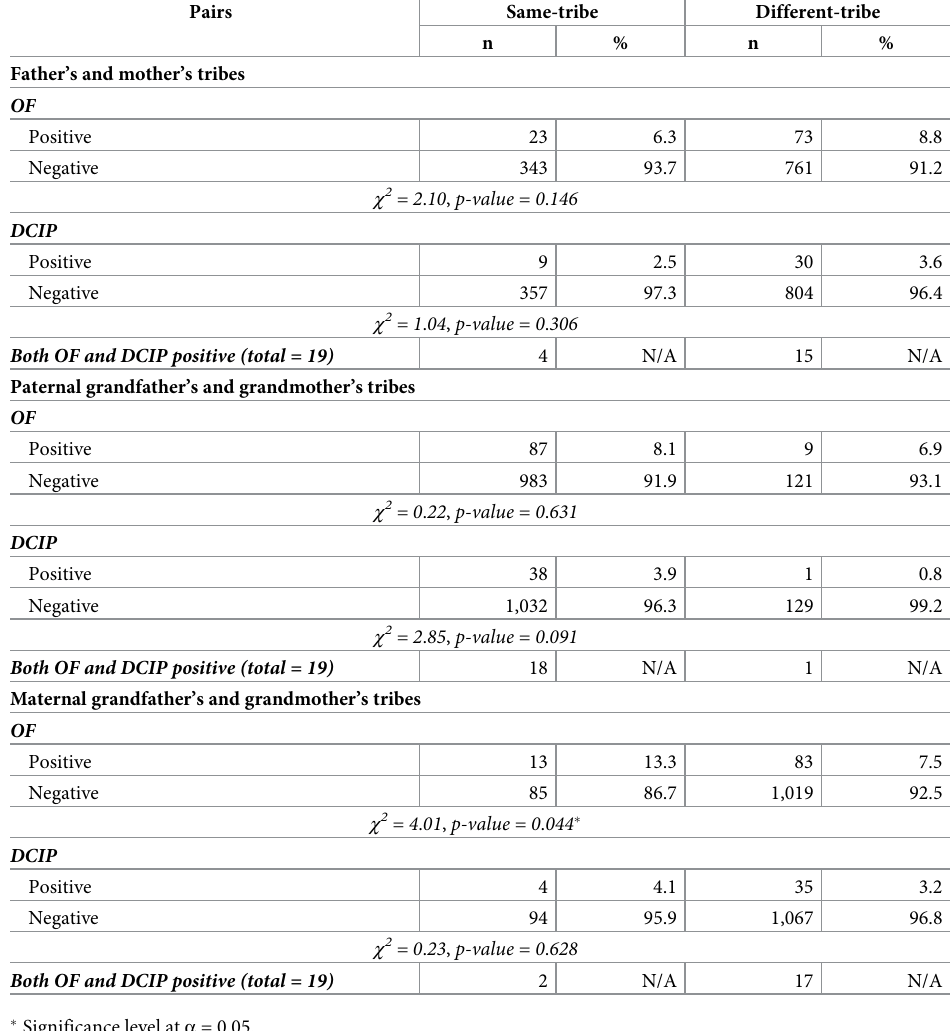
Table 5. Proportions of OF and DCIP results in preceding generations. Pairs